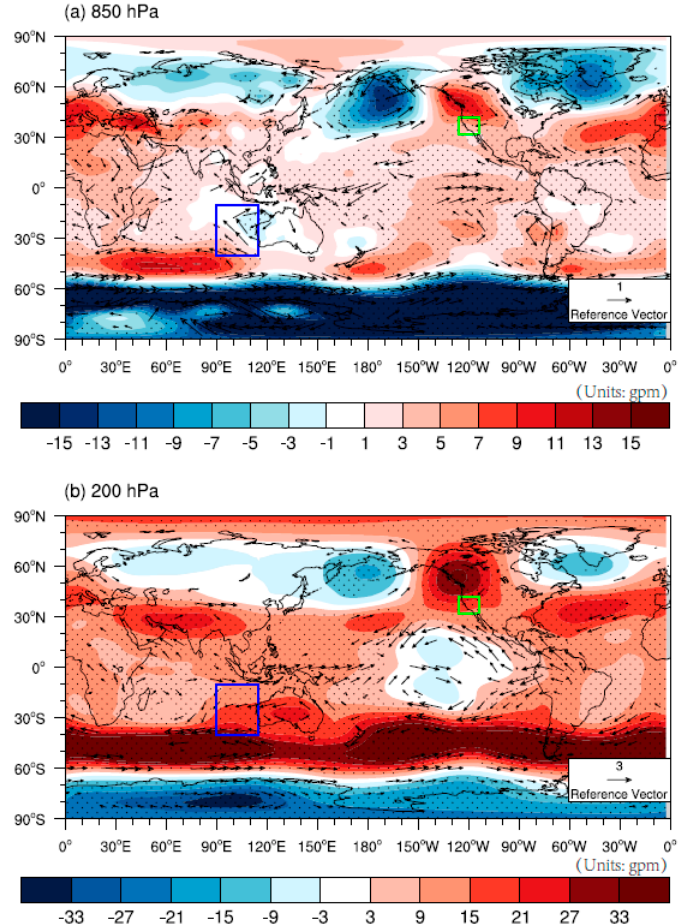
Figure 6. Same as in Figure 4, except that SST is averaged over the blue box.